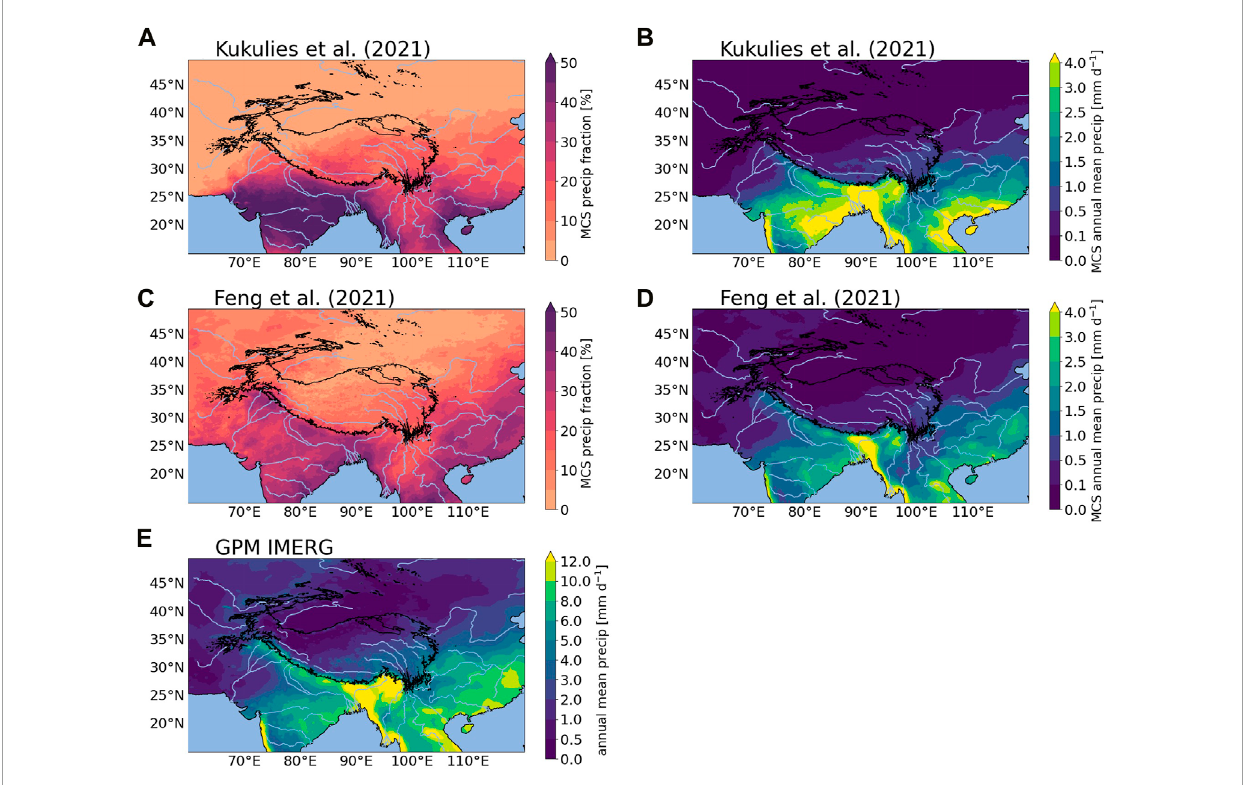
FIGURE 4 Impact of MCSs on precipitation over the TP and its downstream regions over land. Their impact is shown in terms of relative contributions to total annual precipitation [%] (A,C) and absolute annual mean precipitation produced by MCSs [mm] (B, D) , as calculated in Kukulies et al. (2021); Feng et al. (2021b) based on IR brightness temperatures and satellite precipitation estimates. The MCS-associated precipitation is the total sum of precipitation underneath the detected cloud shield. For context, the total annual mean precipitation from GPM IMERG 2000–2019 is also shown in (E)